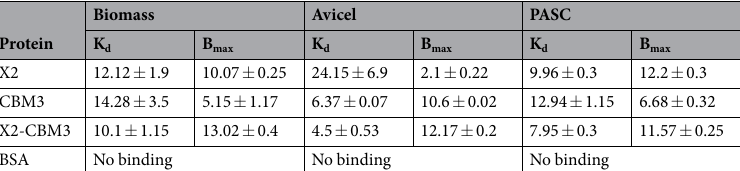
Table 3. Binding affinities and capacities of independent modules towards insoluble substrates as determined by binding isotherms * . * Values for K d ( µ M) and B max ( µ mol/g) were obtained from curve fitting using binding data presented in Fig.